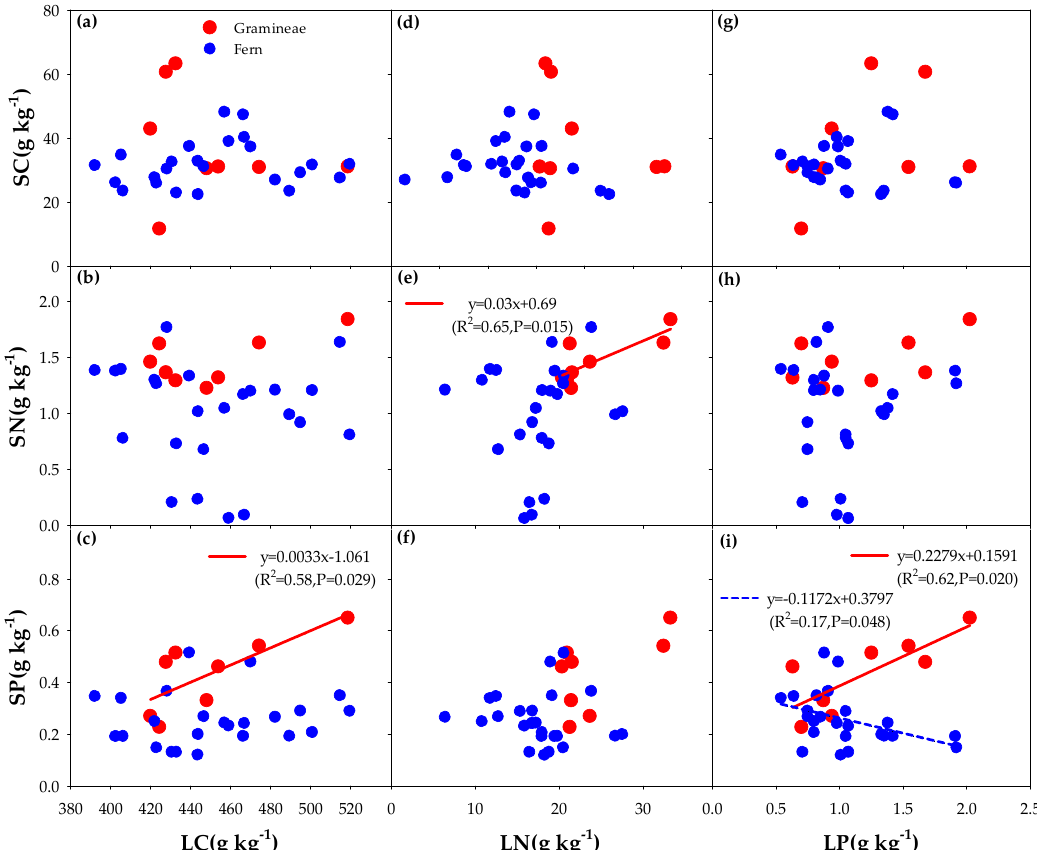
Figure A2. Correlations between litter and soil C, N and P of four dominate species with two di ff erent functional types (Gramineae Lophatherum gracile and fern Woodwardia japonica , Dryopteris atrata and Dicranopteris dichotoma ) in N addition treatment.